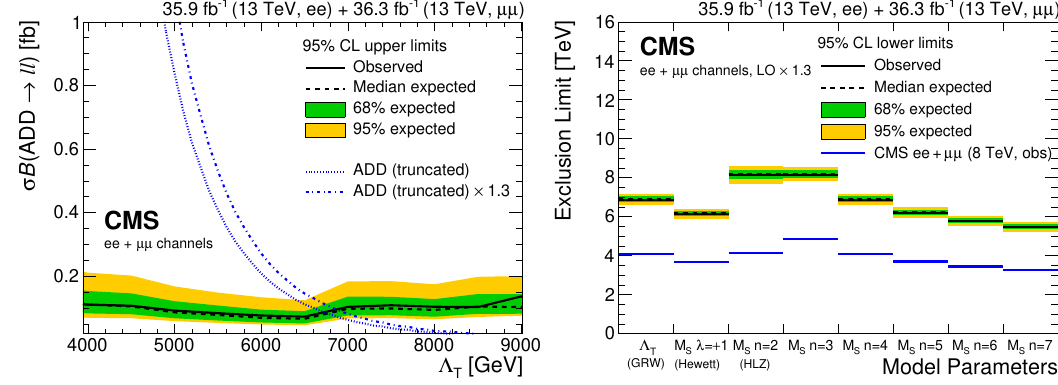
Figure 5 . Combined dilepton 95% CL exclusion limit on the cross section in the GRW convention (left) and on the UV cuto(cid:11) for all parameter conventions (right) with m ‘‘ > 1 : 8 TeV for the ADD model. The curves labeled ADD in the left plot show the theoretical signal cross section calculated by pythia , as a function of the cuto(cid:11) parameter (cid:3) T , and signal contributions with m ‘‘ > (cid:3) T are set to 0. Signal model cross sections are calculated up to leading order and, where indicated by the appropriate label, a correction factor of 1.3 is applied. The results are compared to previous ones from CMS